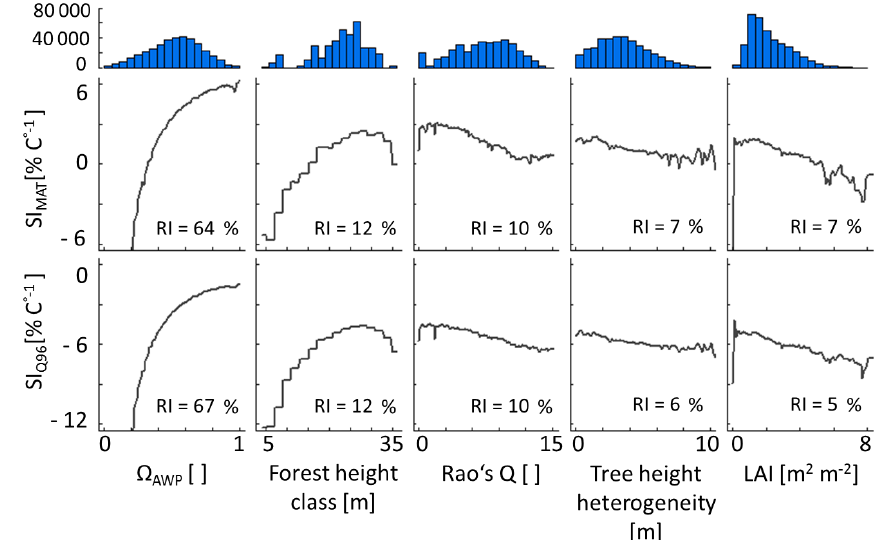
Figure 4. Partial dependency plots of the five forest properties – (cid:127) AWP (species distribution index), forest height class, Rao’s Q (functional diversity), tree height heterogeneity and LAI (leaf area index) – for SI MAT (sensitivity to changes in the mean annual temperature) and SI Q 95 (sensitivity to changes in annual temperature amplitude). Relative importance (RI) compares the influence of different input variables on the variability of a target variable. Histograms show the frequency of forest property values in the analysed data set. Note that (cid:127) AWP is the ratio of the current AWP of a forest and the highest possible AWP obtained by shuffling only species identities without changing the forest structure.